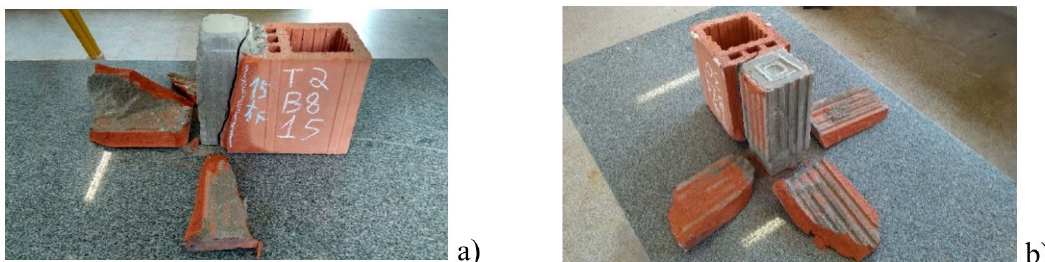
Figure 9. BM16 specimens after push-out